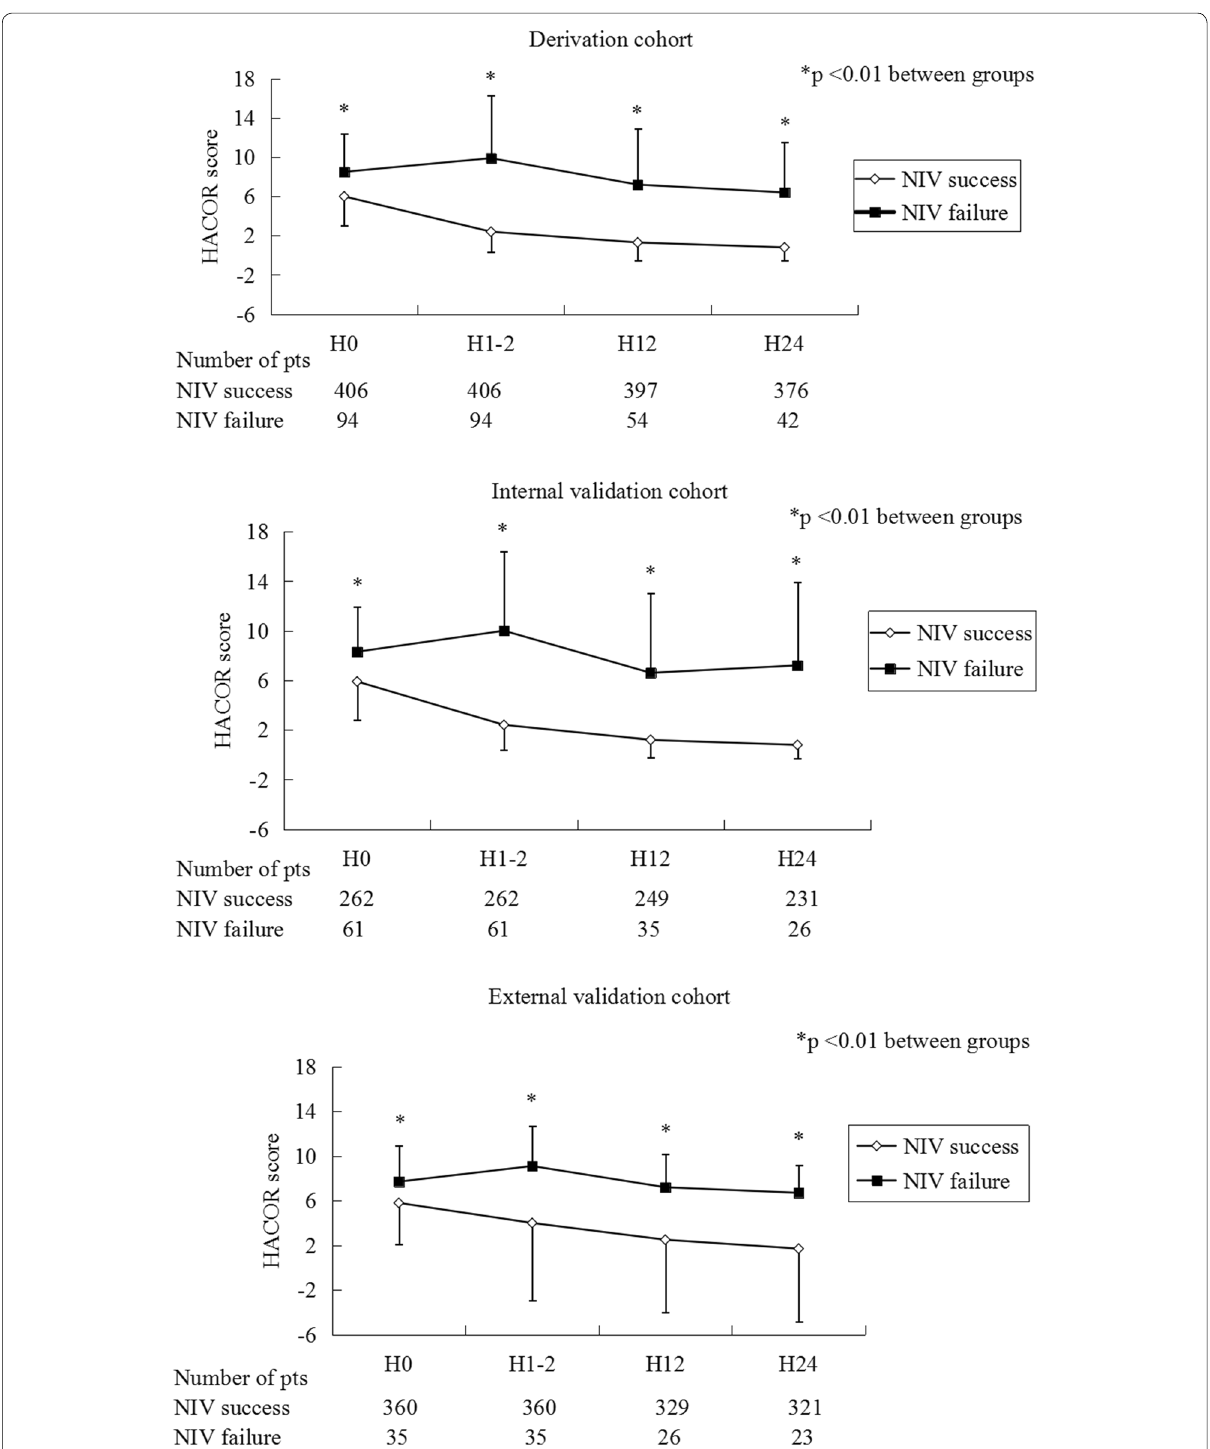
Fig. 1 HACOR scores in patients with NIV success and failure from initiation to 24 h of NIV. Pts patients, NIV noninvasive ventilation, HACOR heart rate, acidosis, consciousness, oxygenation, and respiratory